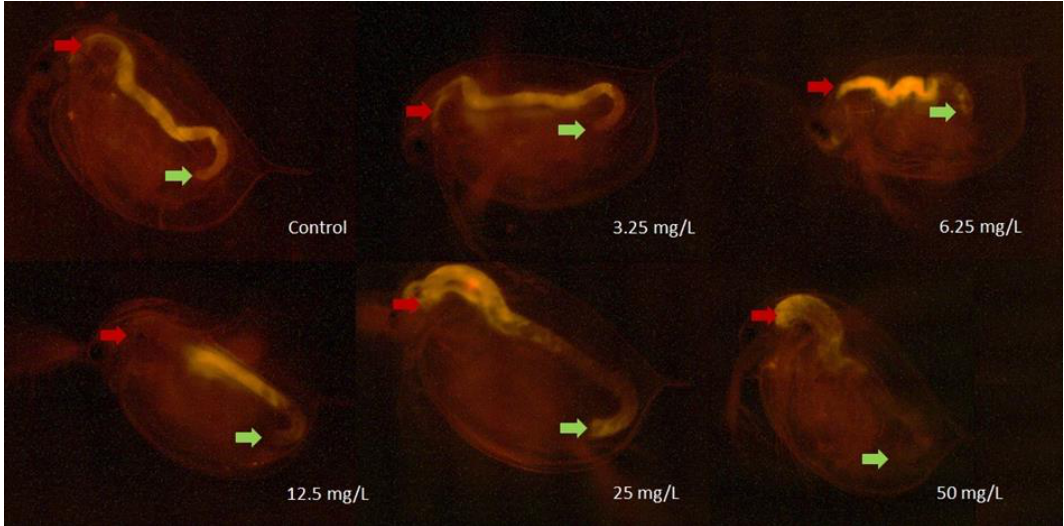
Figure 4. Images of D. magna individuals after 48 h of exposure to different concentrations of GO and after feeding on fluorescent microbeads visualized by fluorescence microscopy (Nikon ECLIPSE E400 fluorescence microscope, 40× magnification, Nikon CFI Plan Achromat 4× objective lens). The beginning of the digestive tract is marked by red arrows, while the end is marked by a green arrow.